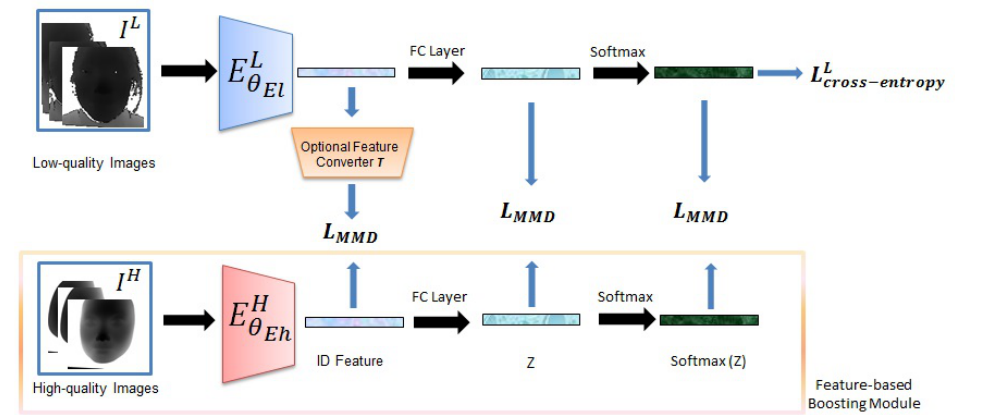
Figure 6. The workflow for feature-based strategy. The blue extractor and orange converter are needed to be trained and red extractor has been pretrained. The feature represented by ID Feature is finally used for FR task. Although the all losses are shown in figure, in different specific methods, the parts of them are used, and details are shown in Section